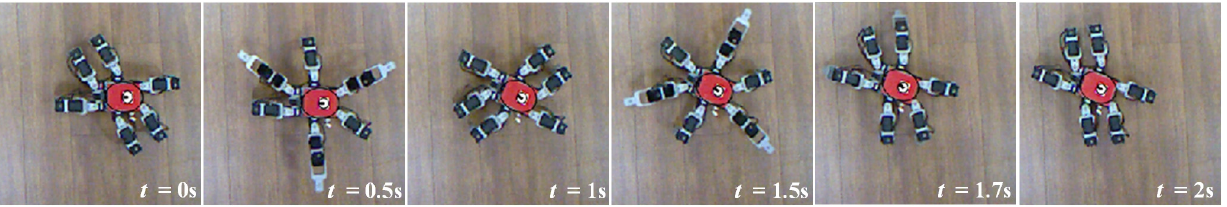
Figure 17. The experimental screenshots of the self ‐ turning gait. During the experiments, the trajectories of the hexapod robot are measured and pre ‐ sented in Figure 18. As shown in Figure 18a, the hexapod robot performs the wave gait. The hexapod robot moves about 108 mm within 10 s. The average velocity is 10.8 mm/s. Figure 18b presents the trajectory of the hexapod robot when it performs the tetrapod gait. The hexapod robot moves about 255 mm within 10 s. The average velocity is 25.5 mm/s. The trajectory of the hexapod robot performing the tripod gait is shown in Figure 18c. The hexapod robot moves about 378 mm within 10 s. The average velocity is 37.8 mm/s. There is a deviation in the moving direction when the hexapod robot performs the above three gaits. As shown in Figure 18d, the trajectory of the self ‐ turning gait is recorded. The hex ‐ apod robot rotates around the z ‐ axis counterclockwise. The hexapod robot rotates about 260° within 10 s. The average rotational speed is 26°/s. The experimental results show that